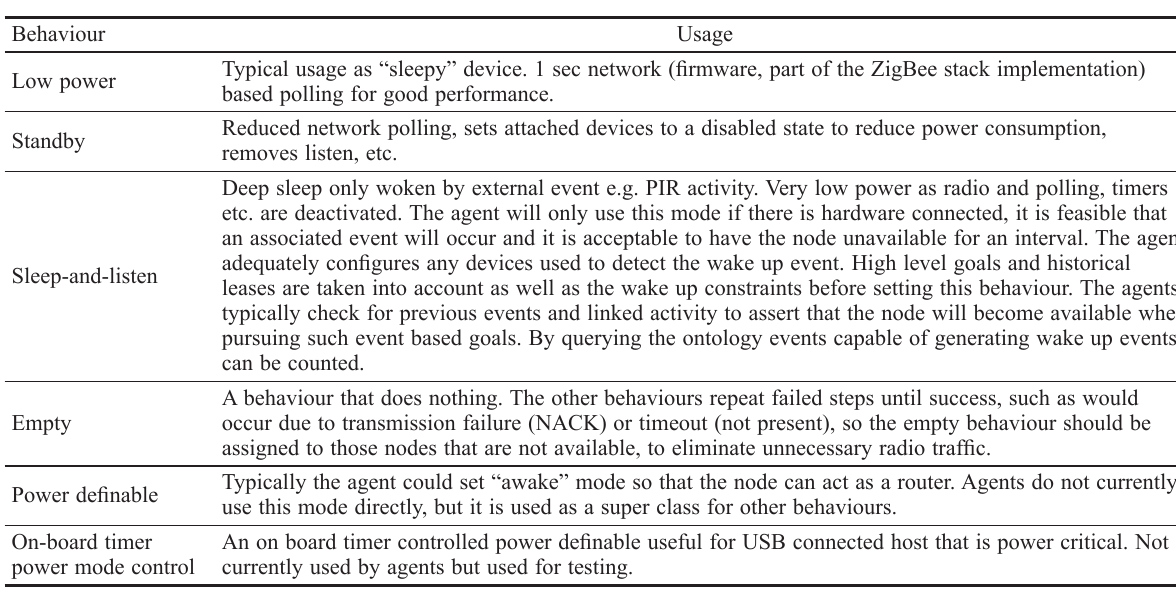
The user interfaces for the zigbee network (shown in Fig. 5) are primarily for status display and a facility to assign “behaviours” to sensor nodes was implemented for testing purposes. in Figure 5, “sensor node” screen- shot shows data collecting information – reading in data through digital i/O etc.; the “ZigBee network interface” shows the communication between different sensors. The arrows represent communication channels and indicate the direction of the flow of data. Those behaviours con - sist of some configuration commands and the issuing of some write commands that enabled visual diagnostics (the development kit units have leD status indicators on some of the channels). For the next integration stage, a utility agent was developed to, in a controlled and pre- dictable way, request leases, read and log